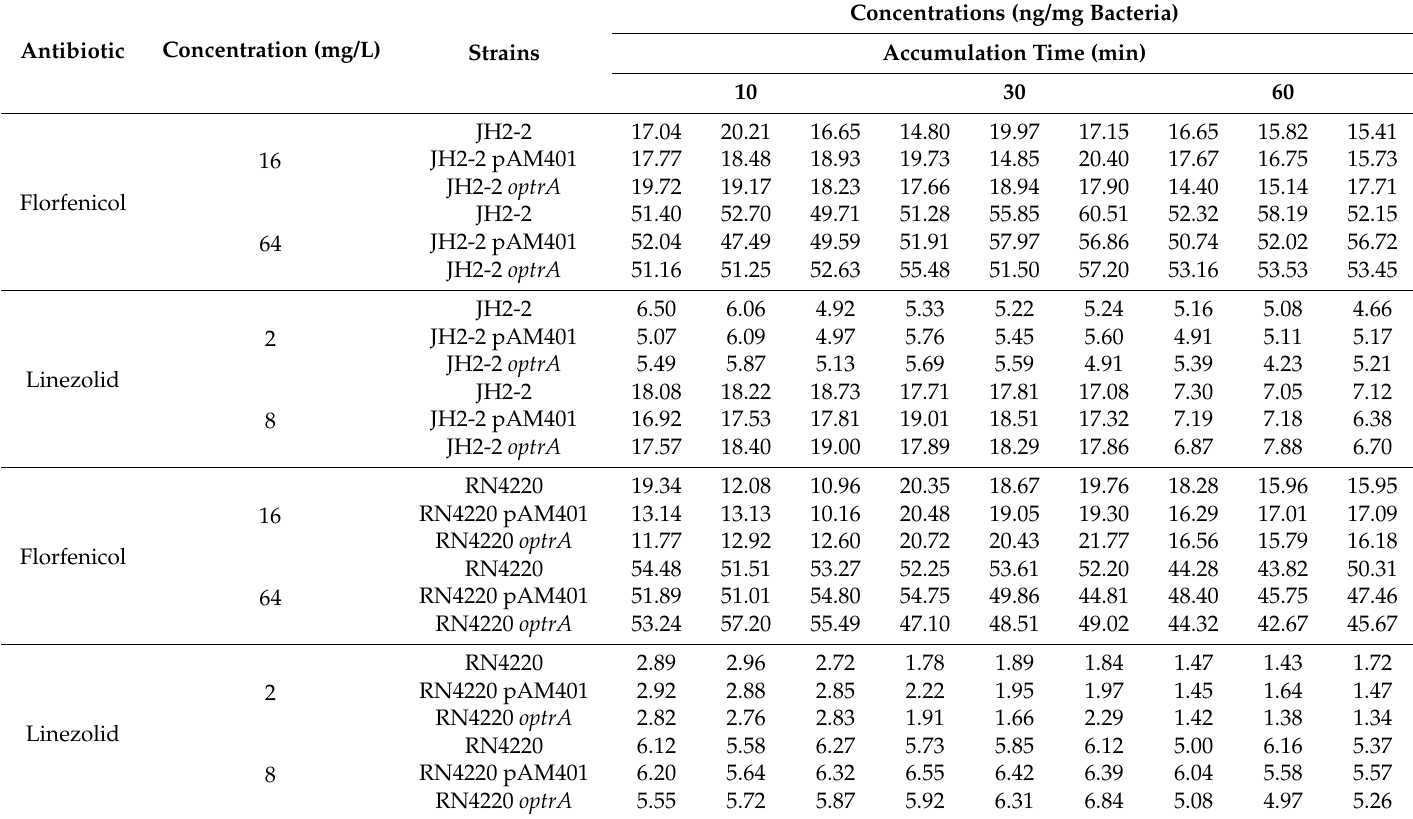
Table 1. Concentrations of florfenicol and linezolid in E. faecalis and S.